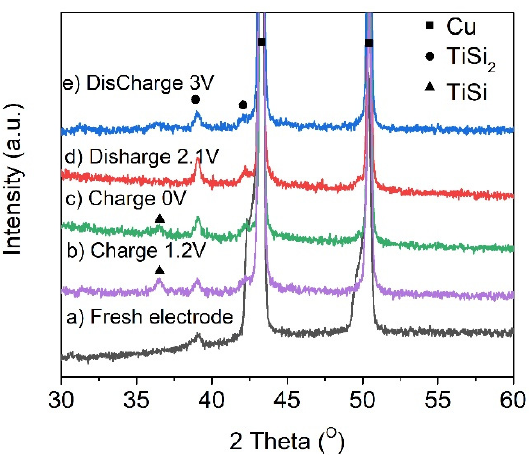
Figure 4. XRD patterns of TiSi 2 /RGO electrode at different charge/discharge potentials.